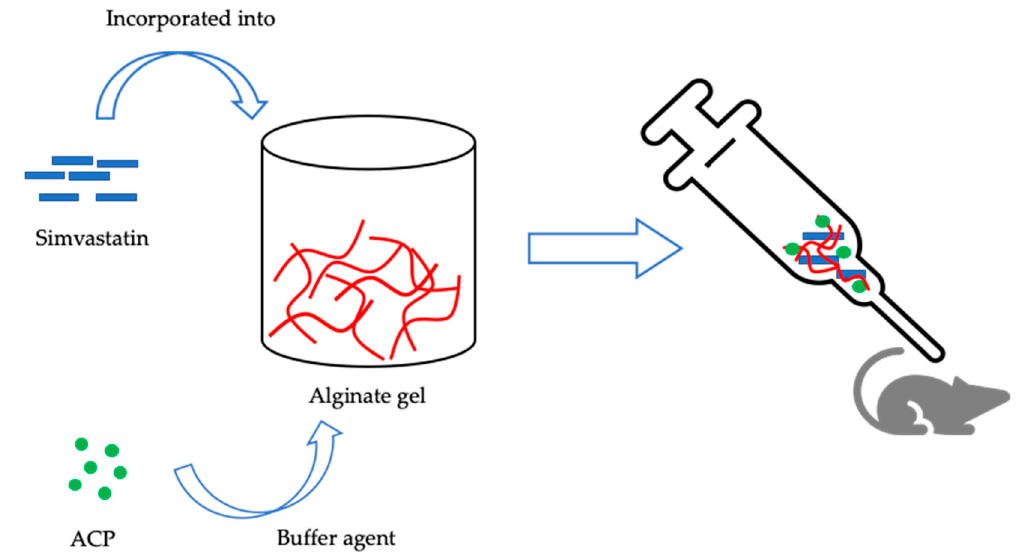
Figure 3. Scheme representing the preparation of simvastatin-loaded alginate gel which becomes a soft carrier after injection in mice. Amorphous calcium phosphate (ACP) acts like a buffer to avoid acidification of the gel-environment prolonging drug release.